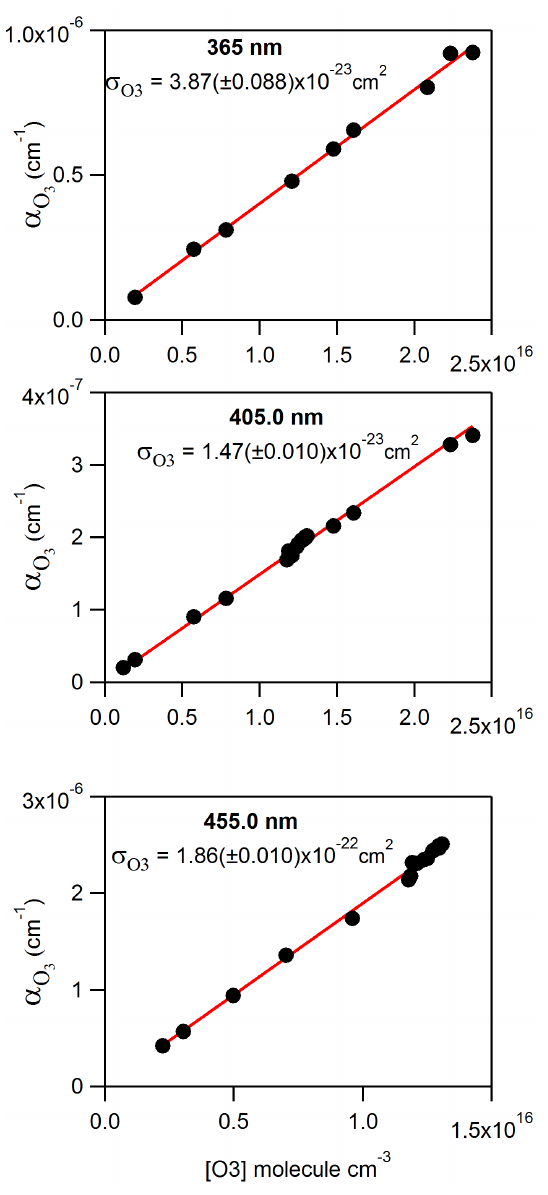
Fig. 5. Optical extinction measurements at various O 3 concentra- tions whose slope is the absolute absorption cross Figure 5. Optical extinction measurements at various O